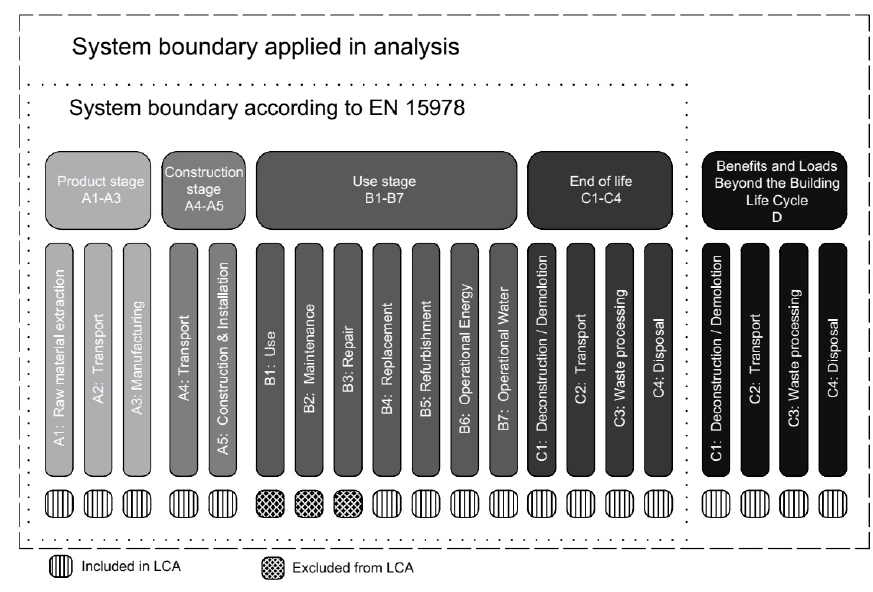
Figure 2. System boundary definition.